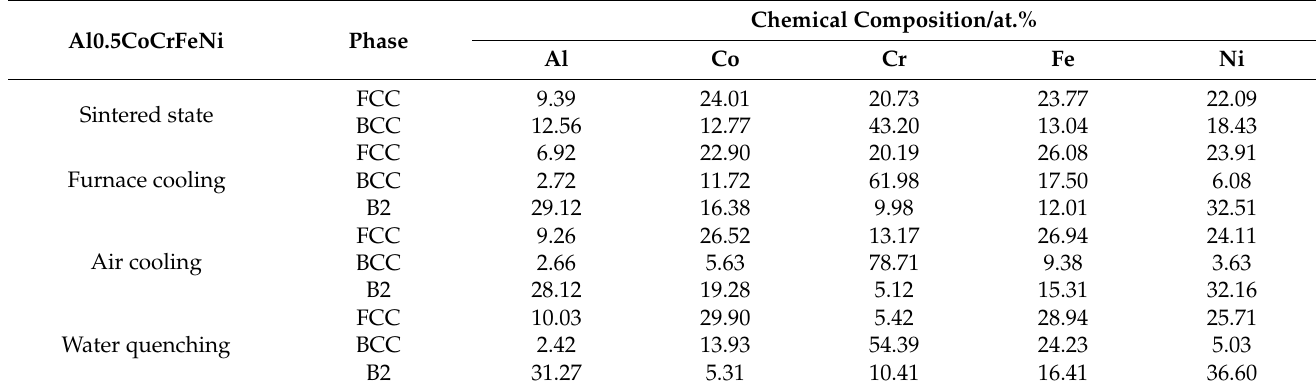
Table 1. EDS analysis results (in at%) of Al 0.5 CoCrFeNi HEA micro-domains in the sintered state and treated with different cooling rates; see Figure 3 for the specific